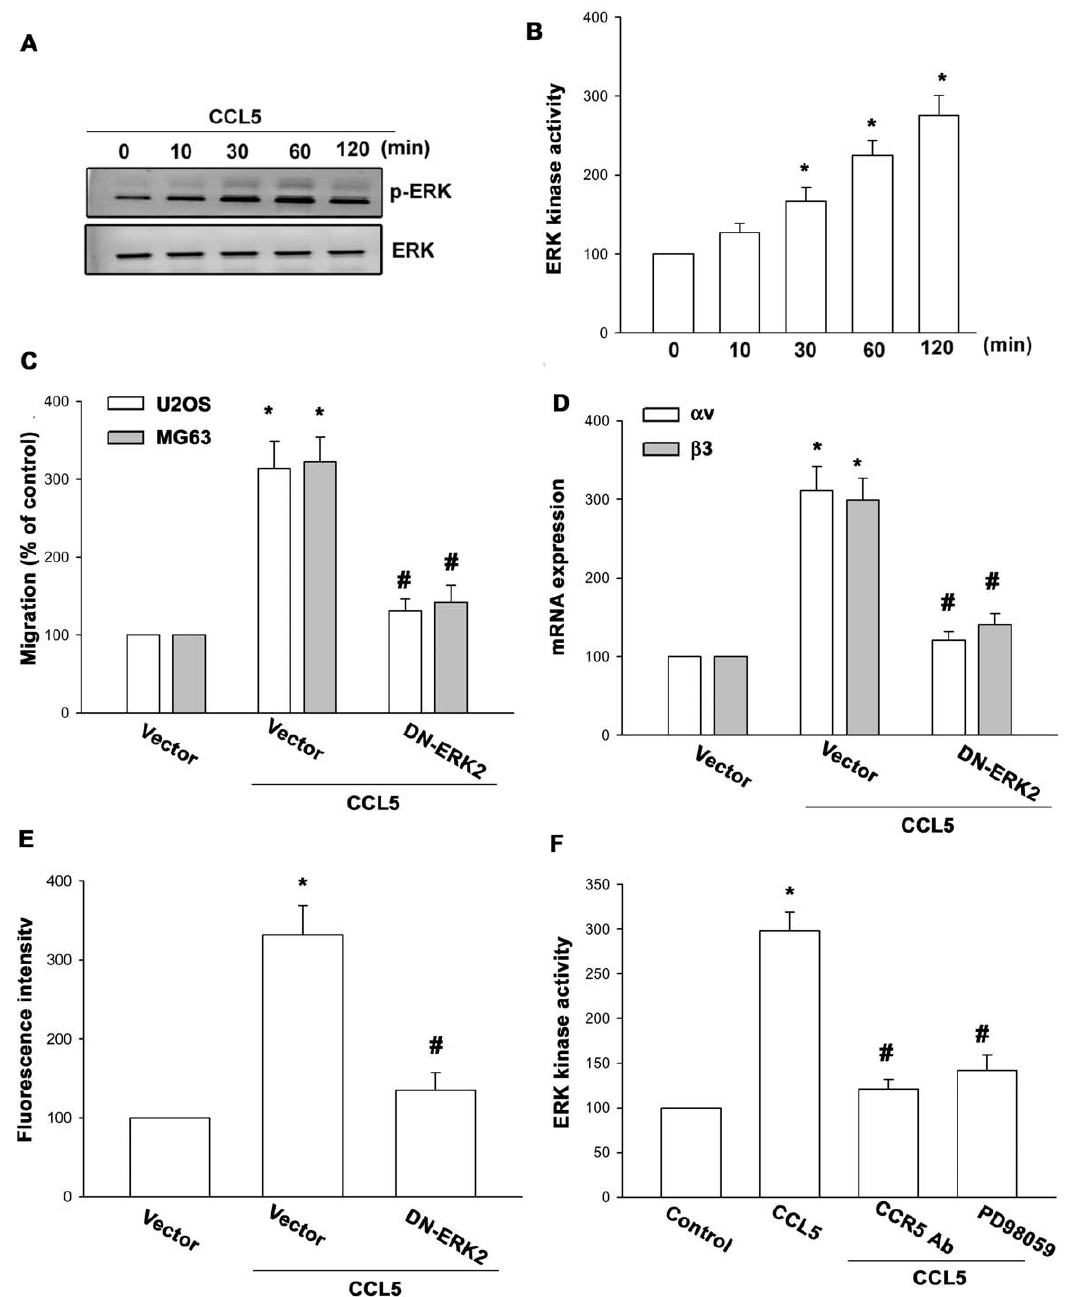
Figure 4. ERK is involved in CCL5-mediated migration in human osteosarcoma cells. (A) MG63 cells were incubated with CCL5 for indicated time intervals, and p-ERK expression was determined by Western blotting. (B) MG63 cells were incubated with CCL5 for indicated time intervals, and ERK kinase activity was examined by ERK kinase assay kit. (C–E) MG63 or U20S cells were transfected with dominant negative (DN) mutant of ERK2 for 24 h followed by stimulation with CCL5. The in vitro migration and integrin expression was examined by Transwell, qPCR, and flow cytometry analysis. Results of five independent experiments performed are expressed. Results are expressed as the mean 6 S.E. *, p , 0.05 compared with control; # , p , 0.05 compared with CCL5-treated group. expression after CCL5 stimulation, incubation of cells with CCL5 increased the MMP-2 mRNA expression but not others MMP (Figure S2). Pretreatment of cells with CCR5 mAb, PD98059, U0126, PDTC, or TPCK reduced CCL5-incrased MMP-2 expression (Figure S2). Therefore, the same signaling pathway involved in CCL5-induced cell migration and MMP-2 expression.